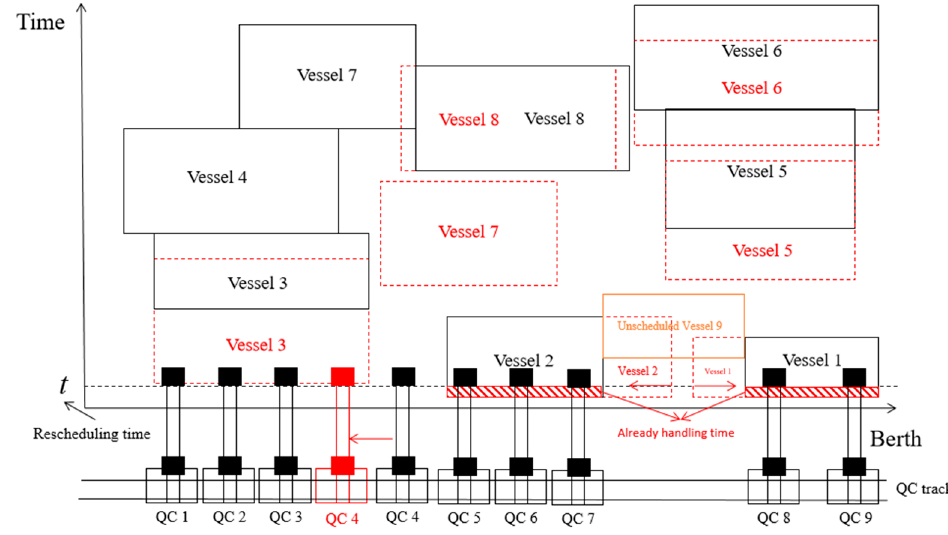
Figure 2. Rescheduling strategies